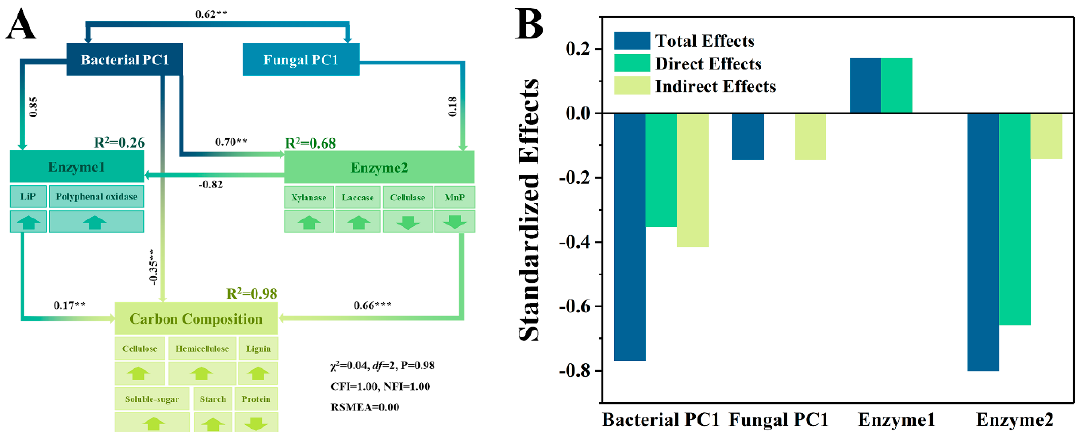
Figure 3. Structure equation modeling resolving carbon composition variations. ( A ) depicts the model, the up and down arrows indicate positively and negatively correlated with the extractions, *, ** and *** indicated significantly related at p < 0.05, p < 0.01 and p < 0.001 level, respectively. ( B ) depict the standardized effects on carbon source composition. The LiP and MnP are abbreviations for lignin peroxidase and manganese peroxidase, respectively.